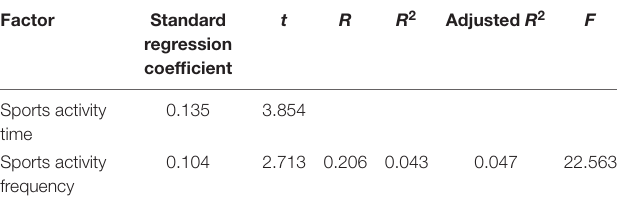
TABLE 7 | Regression analysis of sports activity participation on mental toughness.